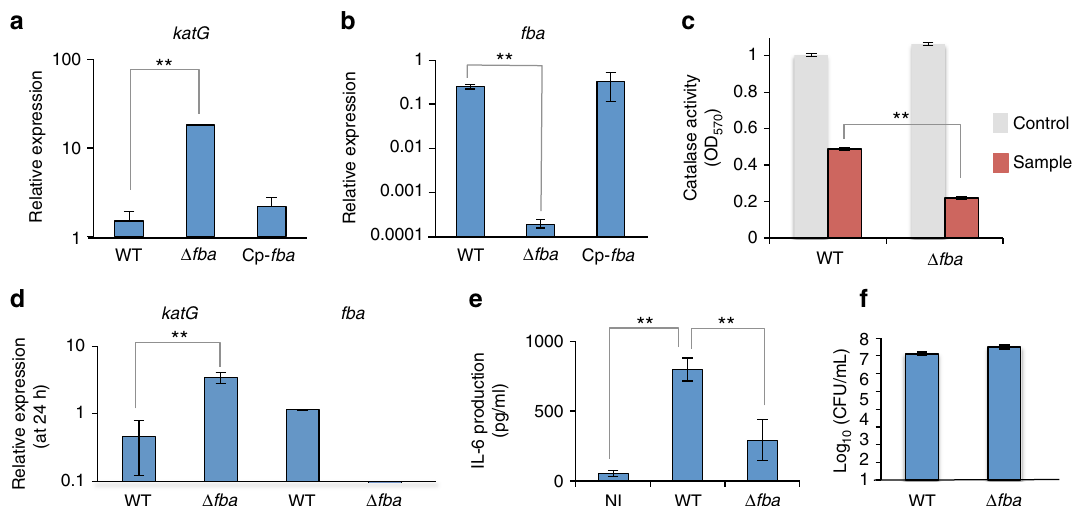
Fig. 5 Quantitative real-time RT-PCR analysis. a , b Bacteria were grown overnight in TSB and qRT-PCR analyses were performed on selected genes, a katG gene or b fba gene in wild-type F. novicida , Δ fba mutant, and fba -complemented (Cp- fba ) strains. For each gene, the transcripts were normalized to helicase rates ( FTN_1594 ). c Catalase activity assay was realized at 570 nm, using the Catalase Assay Kit (ab83464; Abcam). The assay was performed according to manufacturer ’ s recommendation. Each assay was performed on two independent protein lysates. The average of OD 570 ± SD was recorded for wild-type F. novicida and the Δ fba mutant. The catalase activity recorded in the Δ fba mutant was signi fi cantly lower than that recorded in the wild-type strain (** p < 0.01). d J774.1 cells were infected for 24 h with wild-type F. novicida ( WT ) and Δ fba mutant. Total RNA was analyzed by quantitative RT-PCR with katG and fba gene. For each gene, the transcripts were normalized to helicase rates ( FTN_1594 ) (** p < 0.01). e J774.1 cells were infected for 24 h with wild-type F. novicida ( WT ) and Δ fba mutant in DMEM supplemented with glucose and glycerol (25 mM). The supernatants were analyzed by ELISA to detect the amounts of IL-6 produced at 24h in pg mL − 1 . f Intracellular bacterial multiplication of wild-type F. novicida (WT) and Δ fba mutant was determined at 24 h, in the infected J774.1 cells used for the IL-6 dosage, as a control. (** p < 0.01). a – c mean and SD of three independent experiments are shown; d – f each assay was repeated at least three times. Mean and SD of three wells of one typical experiment are shown. p -values were determined by the